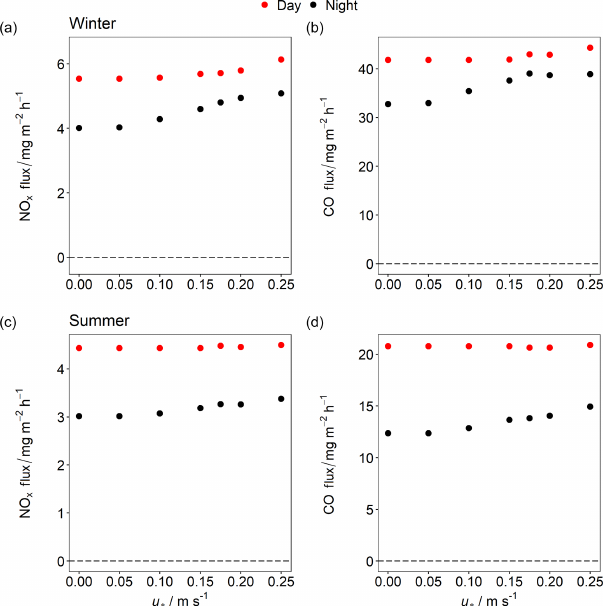
Figure A1. Mean NO x and CO fluxes as a function of different u ∗ thresholds.